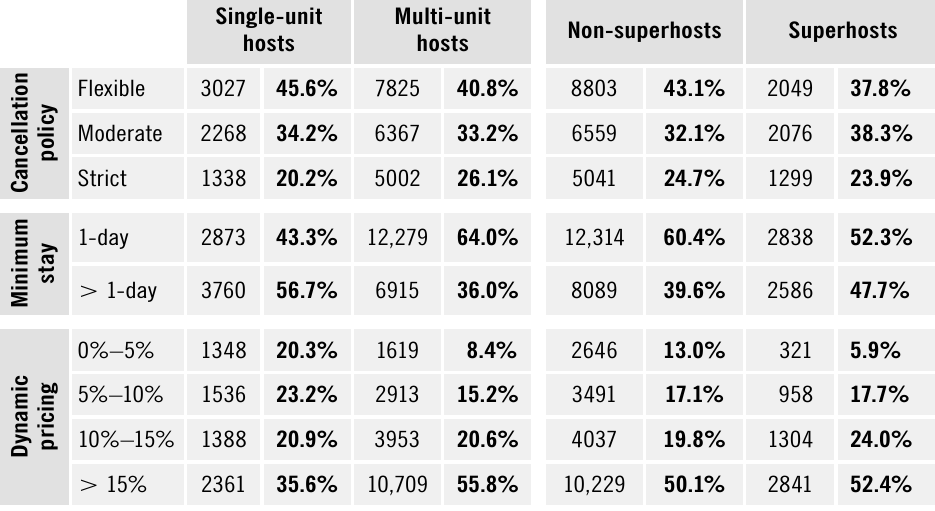
Table 6. Revenue management practices by host